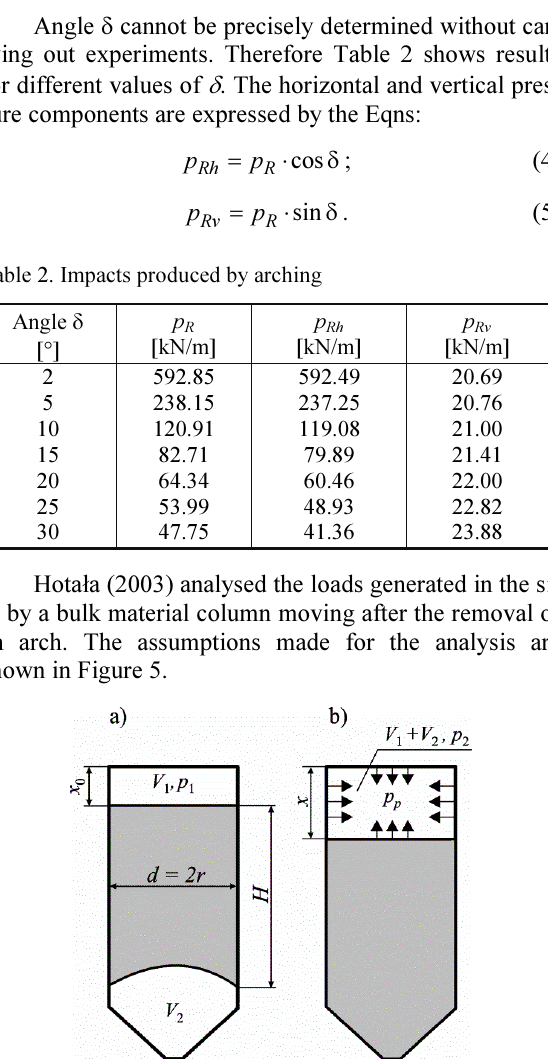
Fig. 4. Assumptions for calculation of pressure generated by arching